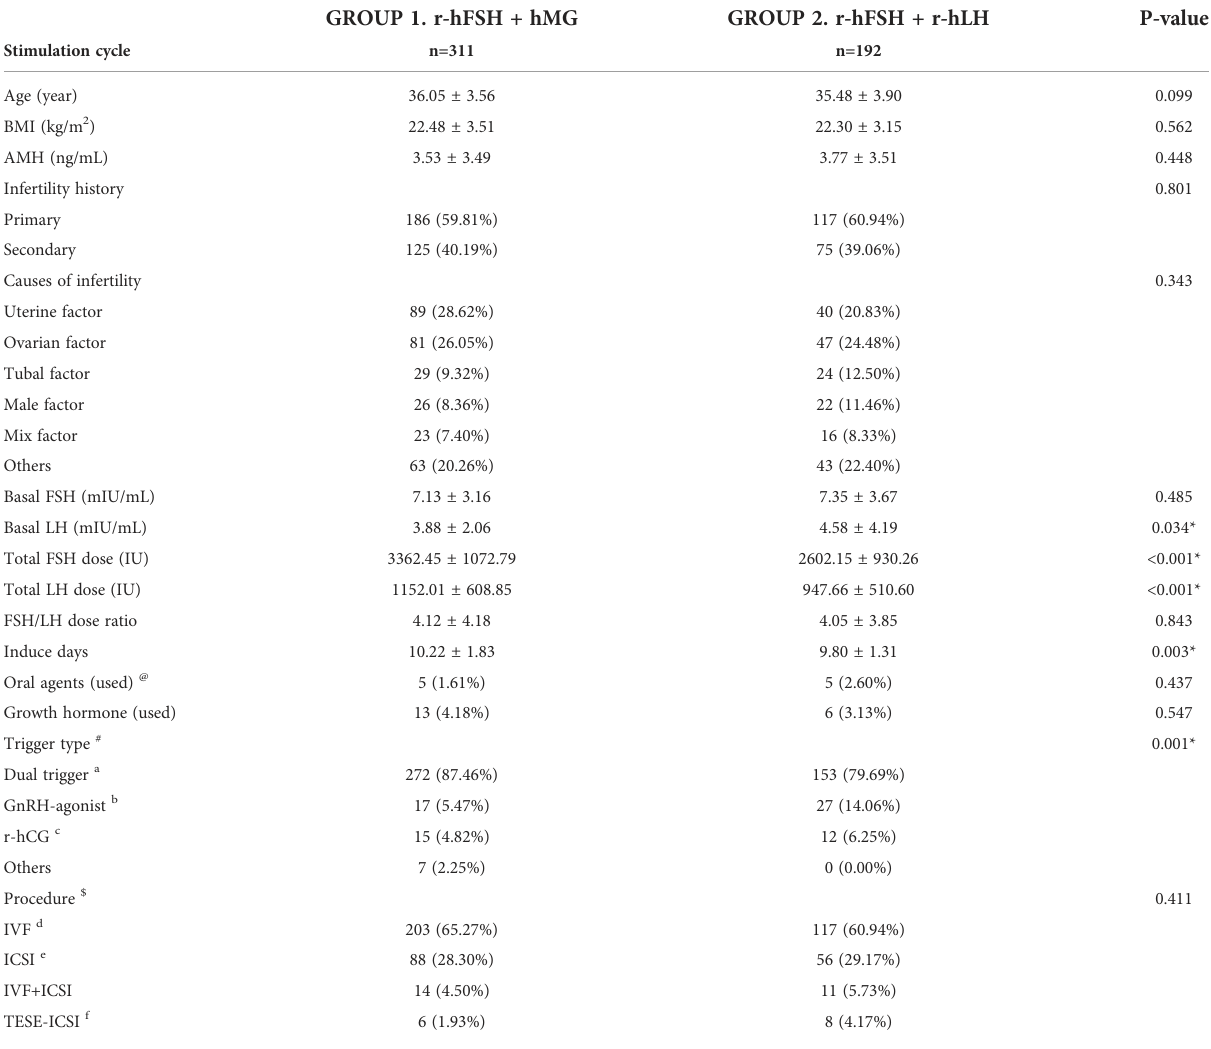
TABLE 1 Baseline characteristics of total stimulation cycles after matching.